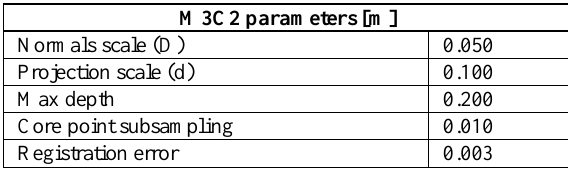
Table 3. M3C2 input parameters for the distance calculation. 4.2 Distance calculation: 3DReshaper compare/inspect tool.